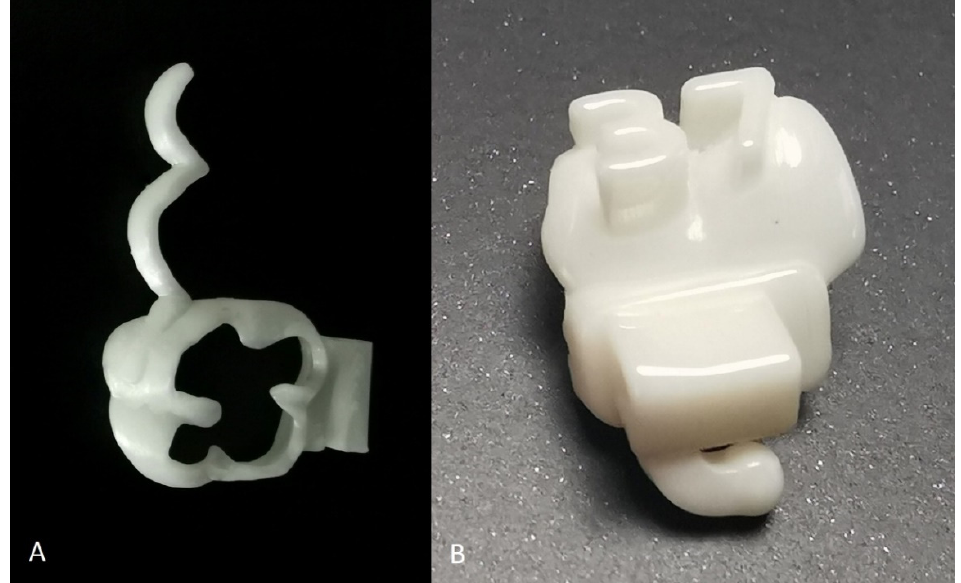
Figure 2. A. Band and RPE arm made of printed zirconia B. A customized tube with its positioning key and tooth number for accurate bonding was designed in Ubrackets CAD